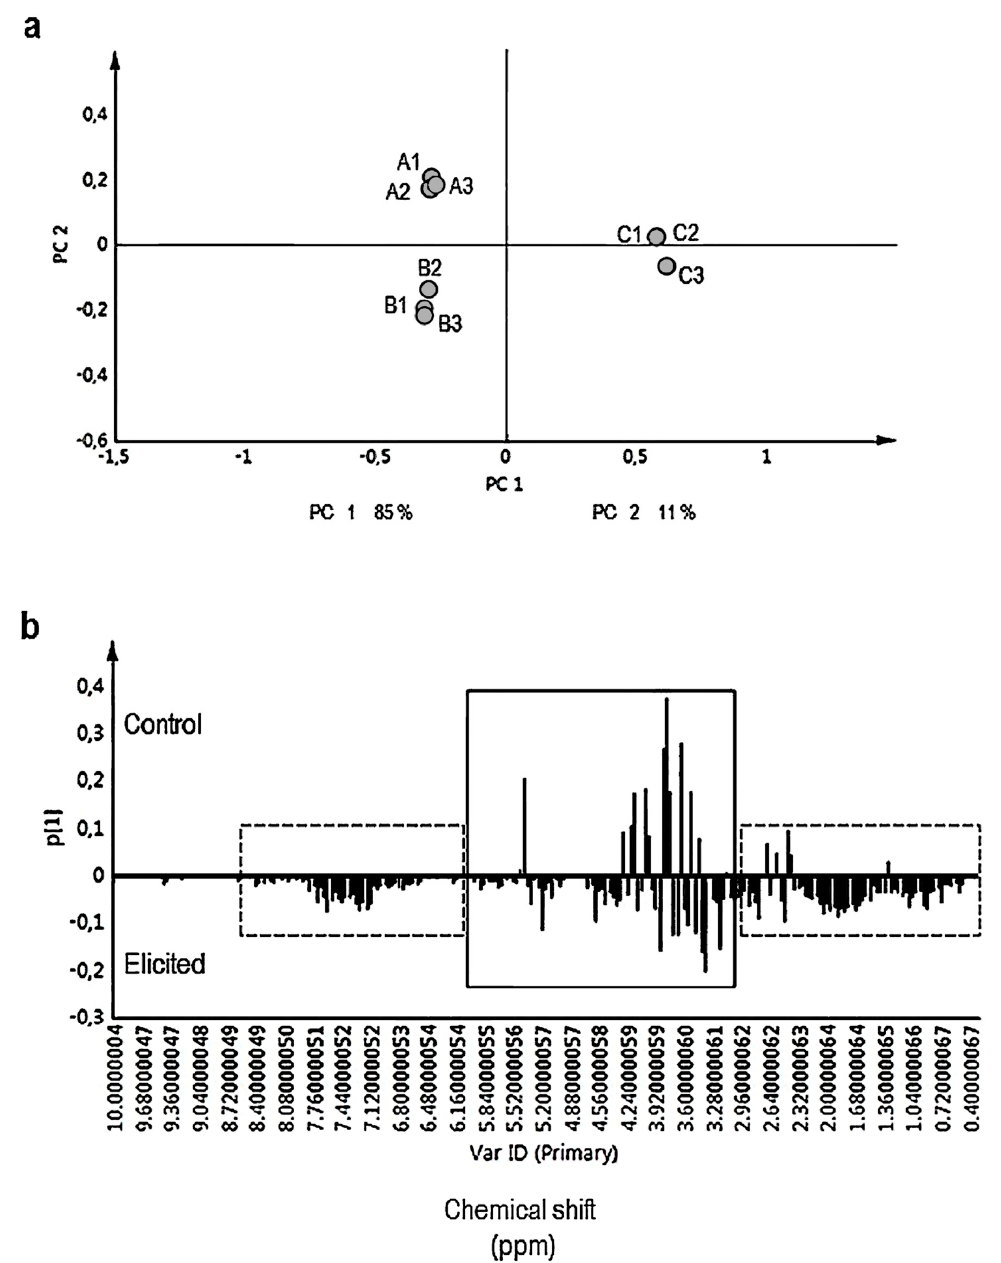
Figure 3. ( a ) Principal component analysis (PCA) score plot and ( b ) loading column plot based on 1 H-NMR data from R. stricta hairy roots exposed to 50 µ M (A1, A2, A3) and 100 µ M (B1, B2, B3) MeJA for three days. In control cultures (C1, C2, and C3) equal volumes of 40% ethanol were applied (the same volume of 100 µ M MeJA). All samples were in triplicate. Elicited samples were e ff ectively separated by PC1 (a). The column plot (b) shows higher levels of aromatics ( δ 6.00– δ 10.00 ppm) and organic/amino acids ( δ 0.00– δ 3.00 ppm) (dashed lines) in elicited hairy root cultures than controls. Continuous line indicates different sugar and fatty acid profiles in elicited and control hairy root cultures.